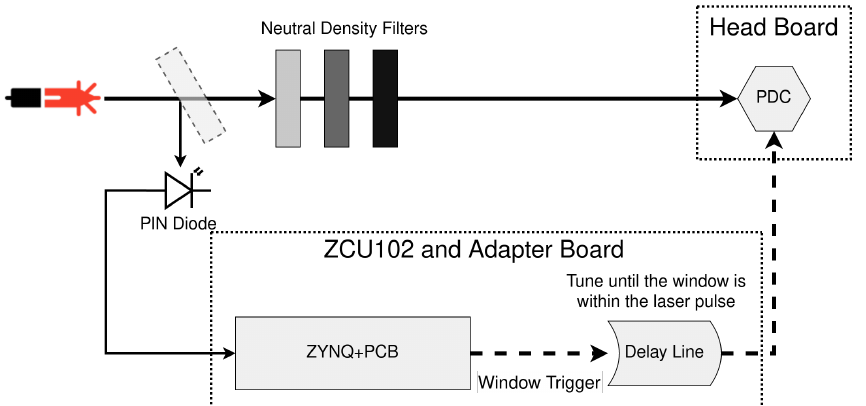
Figure 9. The setup used for the optical tests. The delay between the PCB and the head board of the window trigger signal is controlled on the board via the ZYNQ and Python scripts. The objective is to match the optical with this electronic delay so that the window trigger starts slightly before the arrival of the